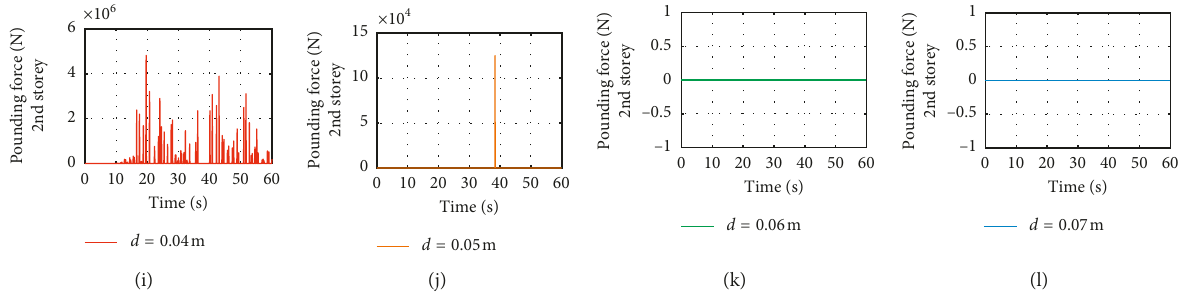
Figure 11: Pounding force time-history with different gaps between buildings during one collision process: (a) 8th storey; (b) 4th storey.